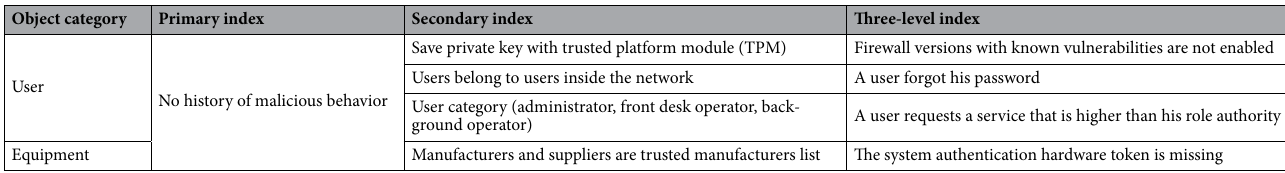
Table 3. Part of network agent security information